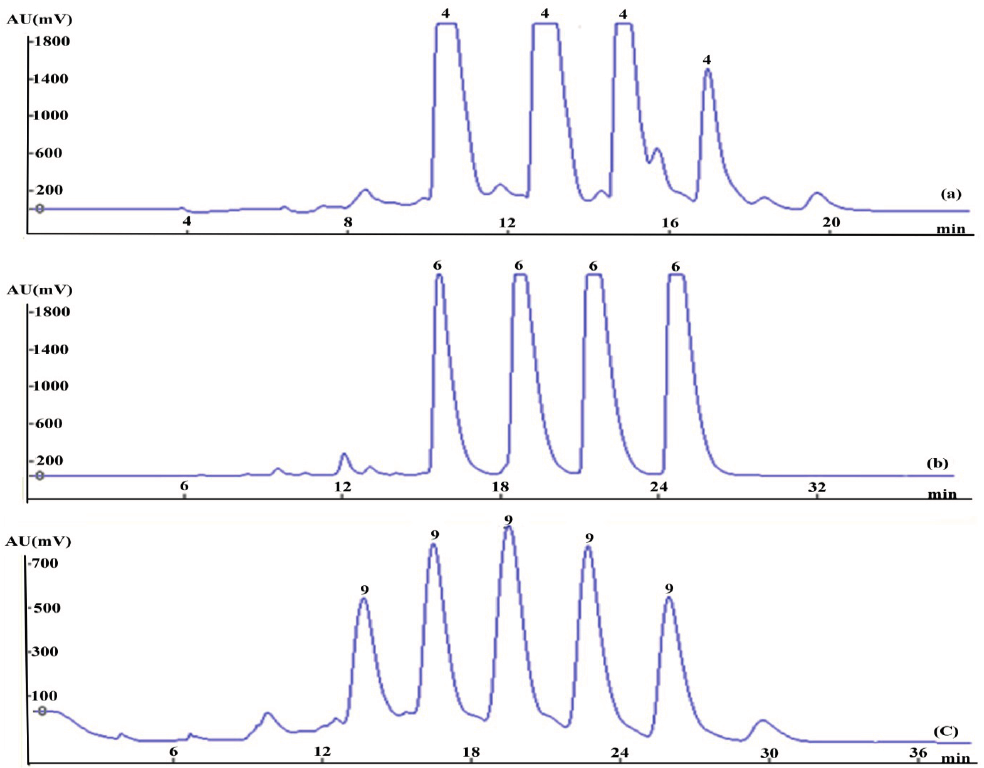
Figure 4. Prep-HPLC chromatograms of 4 ( a ), 6 ( b ) and 9 ( c ), based on online mode separation. 2.2.3. Offline Mode Separation of Compounds 1 , 2 , 3 , 5 , 7 and